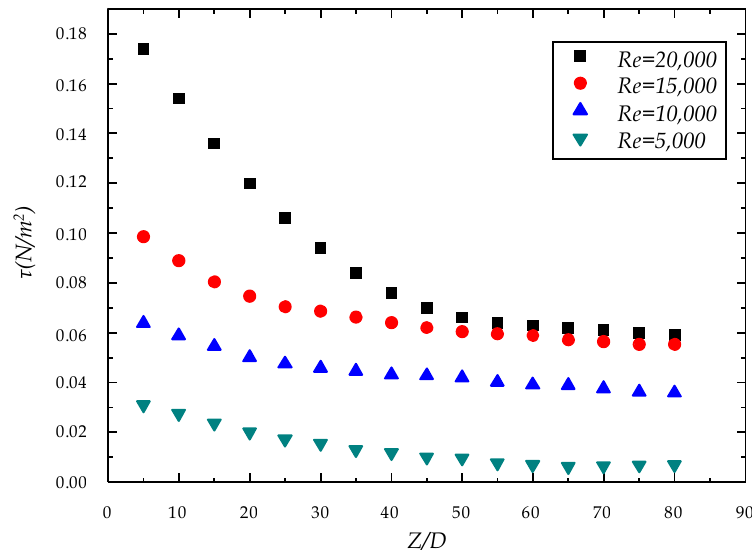
Figure 16. When Y = 6.2, the shear force changes at different positions of different Reynolds numbers.